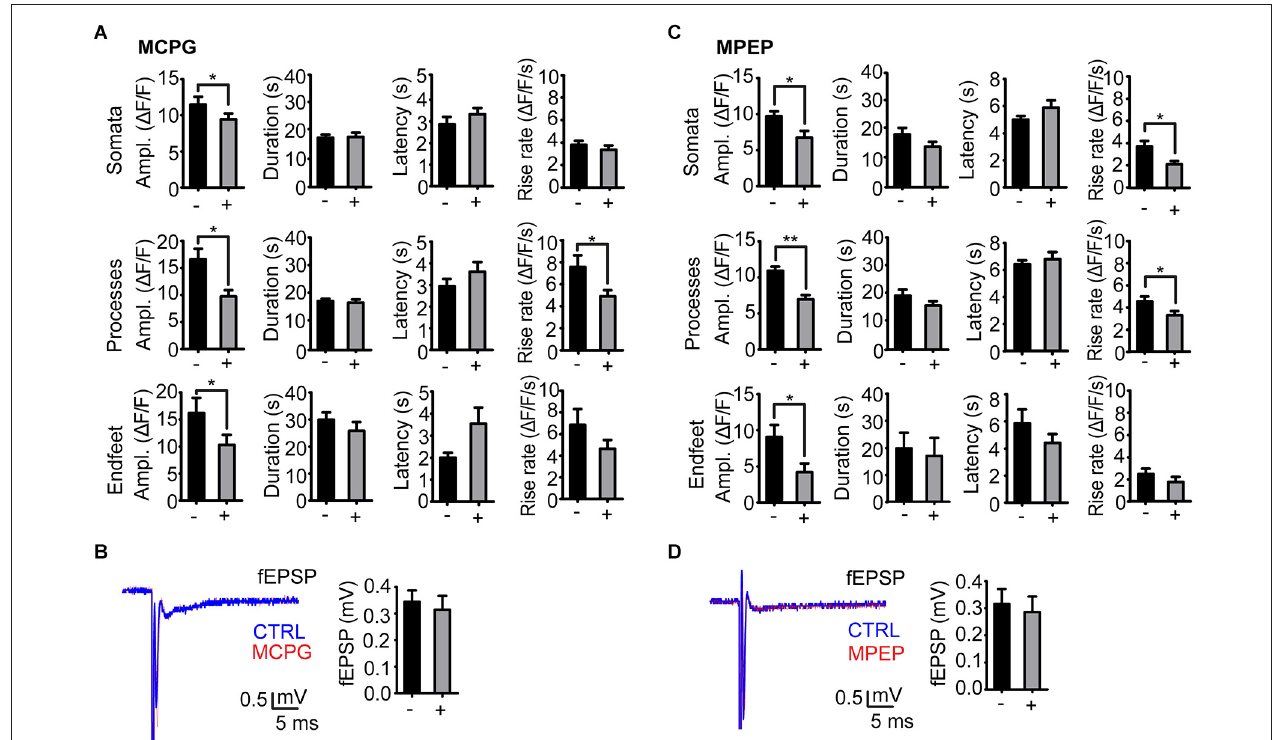
(B) Representative fEPSP traces before (CTRL; blue) and after (red) MCPG administration and mean fEPSP amplitudes. (C) As in (A) , but with MPEP instead of MCPG. (D) As in (B) , but with MPEP instead of MCPG. Values are mean ± s.e.m. Asterisk, P < 0.05. Double asterisk, P <